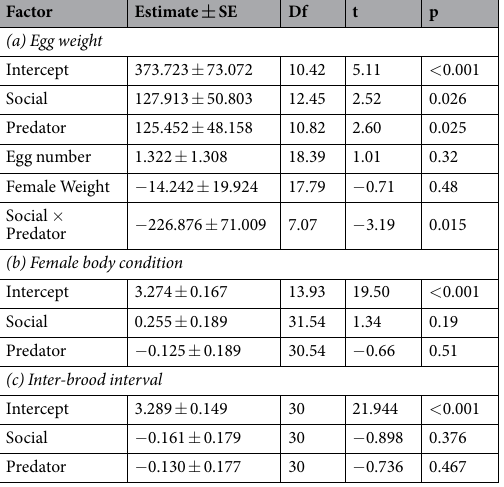
Table 1. Results of linear models to analyse the effect of early social and predator environment on (a) egg weight (LMM, N = 25), (b) female body condition after producing the first clutch (LMM, N = 37) and (c) inter- brood interval between second and third clutch (LM, N = 33).